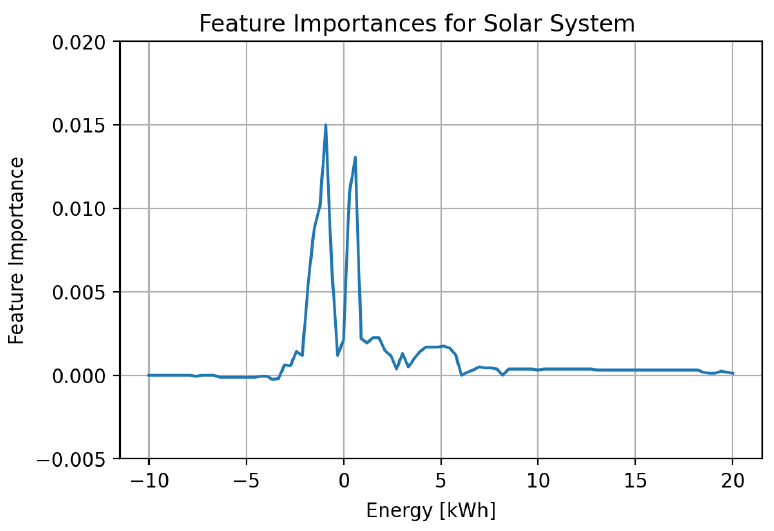
Figure 10. Feature importance of the MLP branch of the Combined Classifier based on the kernel density data of the monthly input time span for photovoltaic system